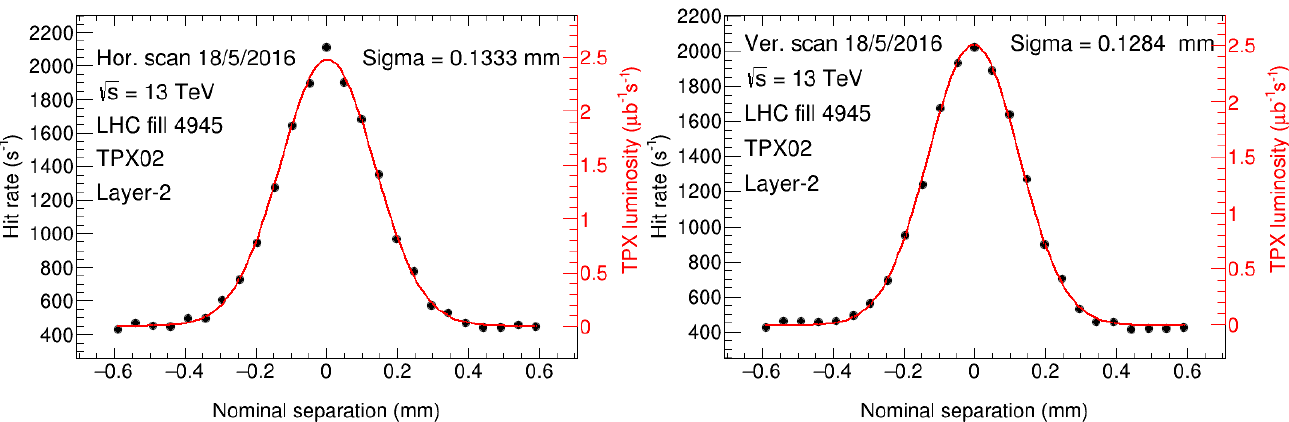
Figure 48. Luminosity from hit-counting as a function of nominal beam separation measured with TPX02 layer 2 during the first horizontal and vertical vdM scan on 18 May 2016. Each data point shows the measured instantaneous luminosity before background subtraction. Because the exposure time is significantly shorter than the duration of a scan step, the TPX samplings are averaged per scan step. The TPX samplings that partially or totally overlap with non-quiescent scan steps (varying beam separation) are not shown. The fit function is the sum of a single Gaussian (representing the proper luminosity in this scan) and a constant term that accounts for induced radioactivity (activation), instrumental noise and single-beam induced background. The TPX normalization uses the horizontal and the vertical beam width. LHC vdM fill 4945. Taken from Ref.